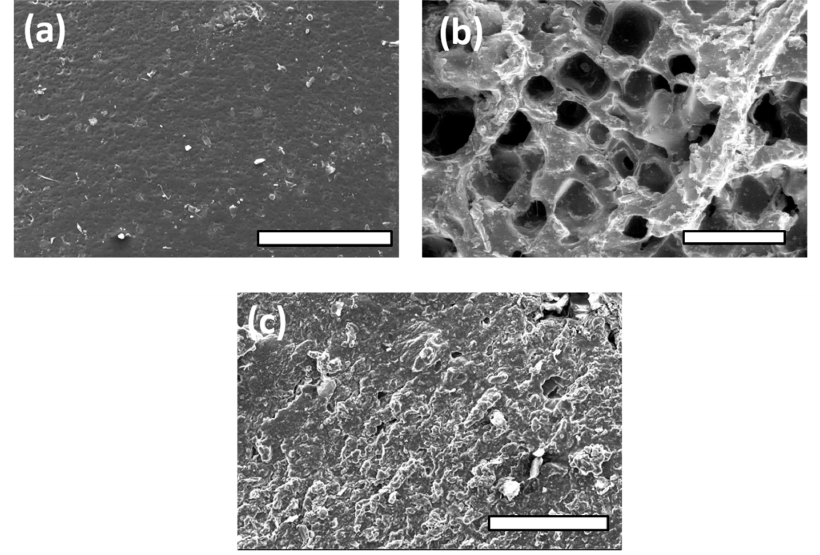
Figure 6. Photographs of elastomer sheets’ surfaces by FE-SEM observations: ( a ) PGFS1; ( b ) PGFS2 (prepolymer after leaching of NaCl in deionized water); ( c ) PGFS2 (after extrusion process). Scale bars = 400 µm for ( a ) and ( c ), and 1 mm for ( b ).